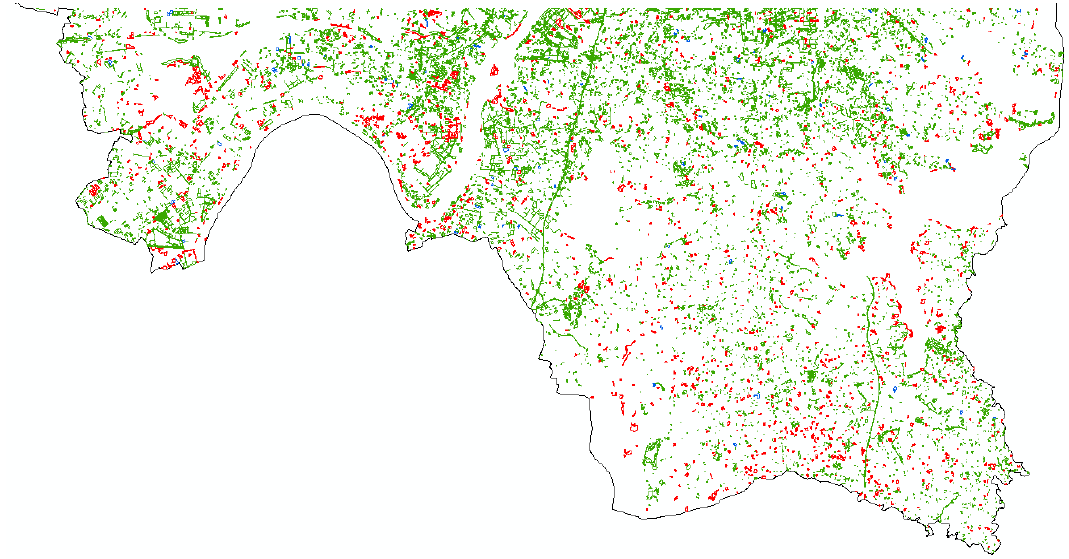
Figure 10. The object-based change map, where the white background is the unchanged area, green polygons are correctly detected changed objects, red and blue indicate respectively false positives and false negatives.